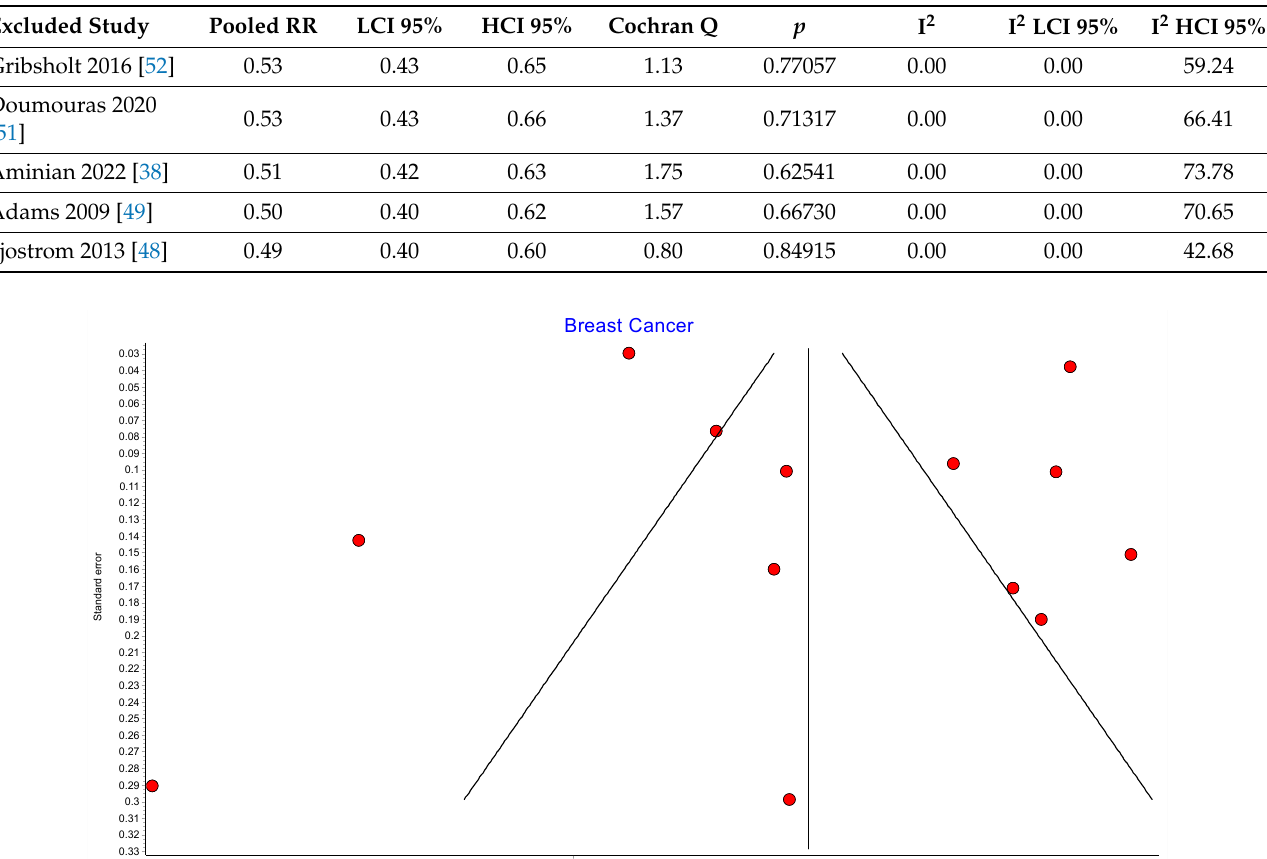
Table A3. Cancer-related mortality sensitivity analysis.